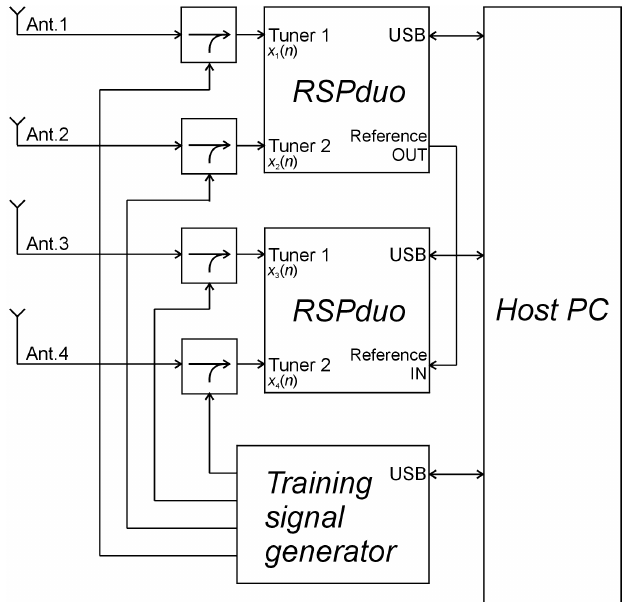
Figure 1. Four-channel receiver used in the experiments.